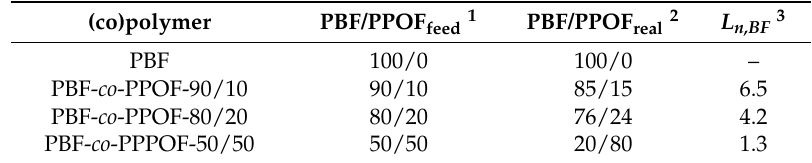
Table 3. Comparison between the initial and the real molar ratio percentages of PBF and PPOF in the polyesters’ backbone.